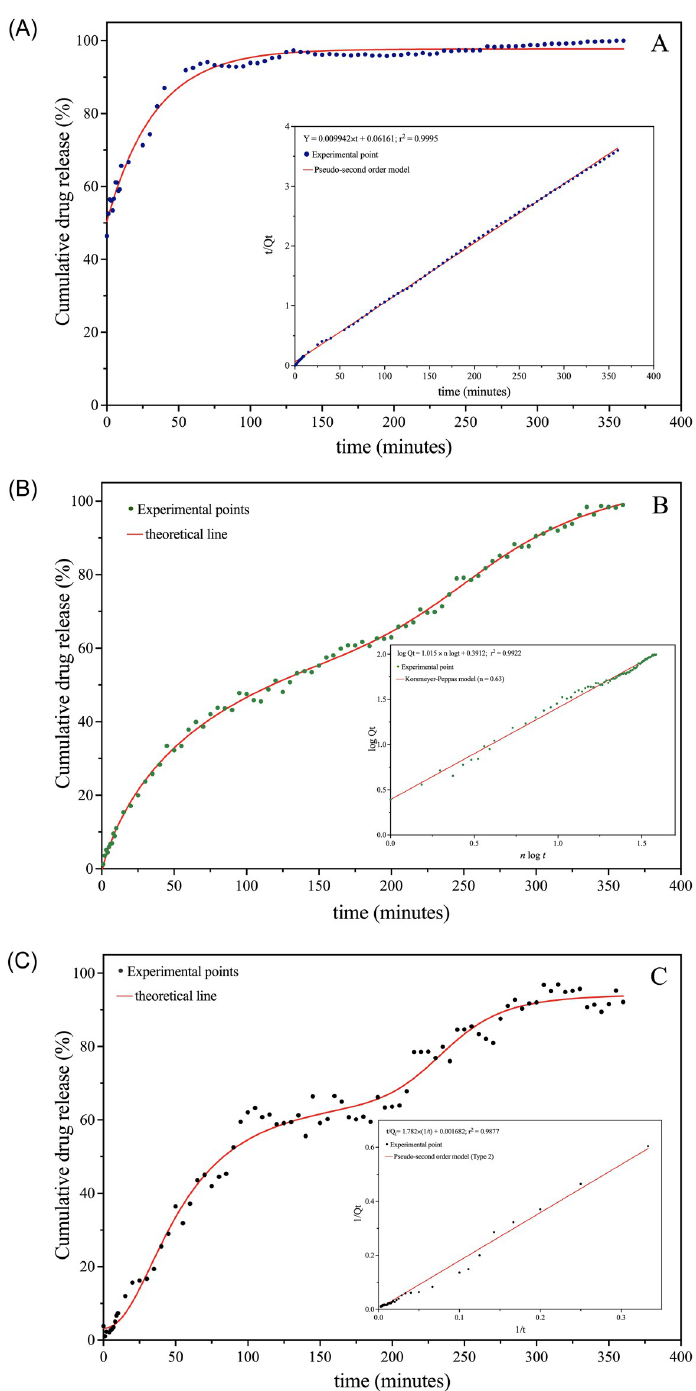
Fig 5. Experimental release profile of E-NP: A) pH 1.0 (dark blue dot), (B) pH 7.4 (green dot) and C) pH 8.5 (black dot), red curve indicate the best fitting curve. Insert: kinetic model graph.